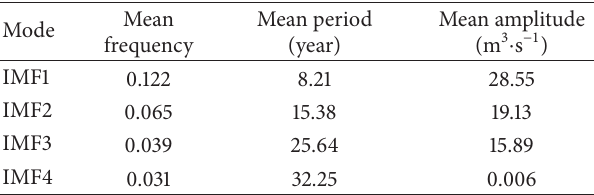
Figure 4: The average annual runoff and the abrupt change points. Table 2: Statistical parameters of the IMFs.